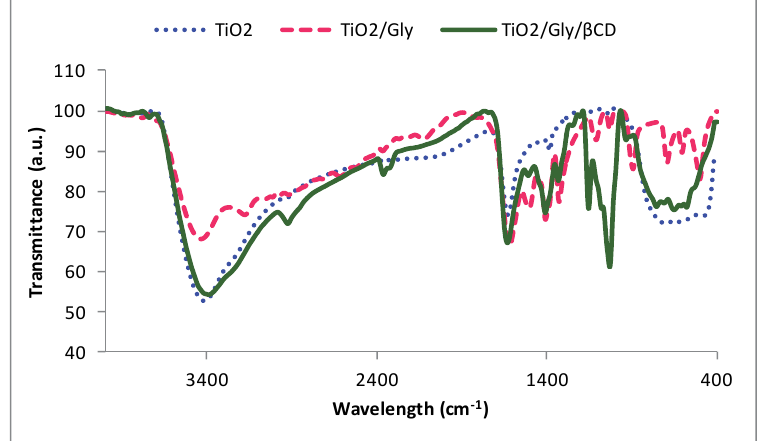
Fig. 1. FT-IR spectra of pure TiO